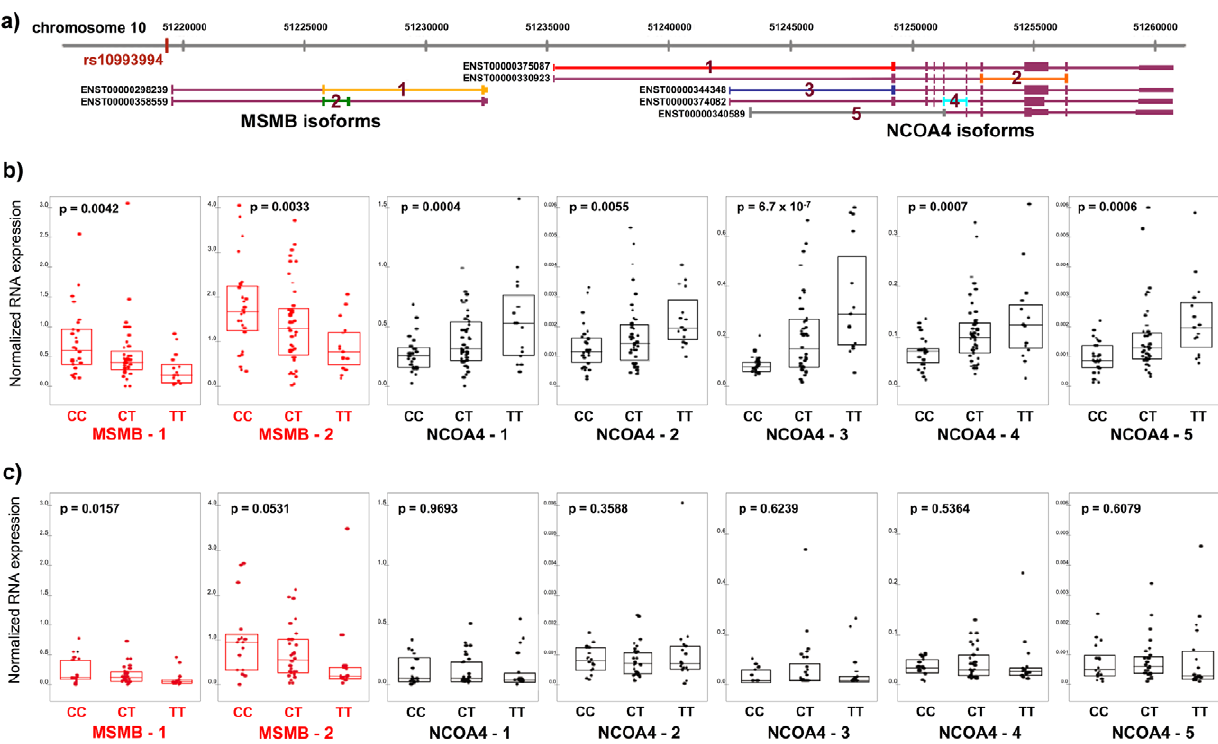
Figure 1. RNA expression of MSMB and NCOA4 in normal and tumor prostate tissue by rs10994994 genotype. A. Chromosome 10q11 with isoforms of MSMB and NCOA4 (Ensembl build 52). Primers for competitive PCR were designed to cross exon-exon boundaries depicted by colored lines 1–2 ( MSMB ) and 1–5 ( NCOA4 ). B. Expression in histologically normal prostate tissue (n=84). Each point represents absolute RNA expression for one individual, normalized to three housekeeping genes. The top and bottom of the boxes within each graph represent the upper and lower quartiles for expression at each genotype. The band inside each box marks the median value. P-value for each graph denotes the significance for association between expression and genotype. C. Expression in prostate tumor tissue in the Dana-Farber Cancer Institute series (n=61).